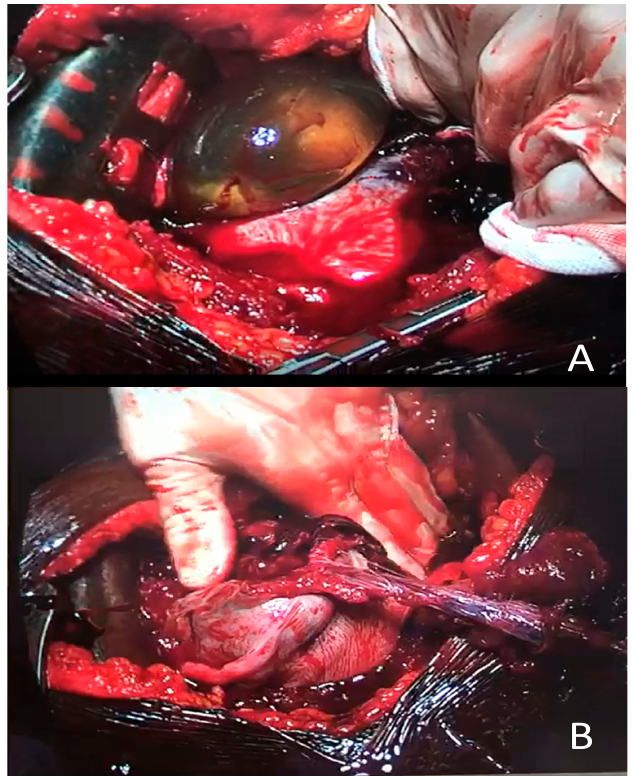
Figure 2. Macro photos after laparotomy: ( A ) Broken uterus with the whole sac containing fetus and placenta expelled in the abdomen; ( B ) extensive and irregular breach on the bottom of the uterus with membranes connected to the expelled sac.